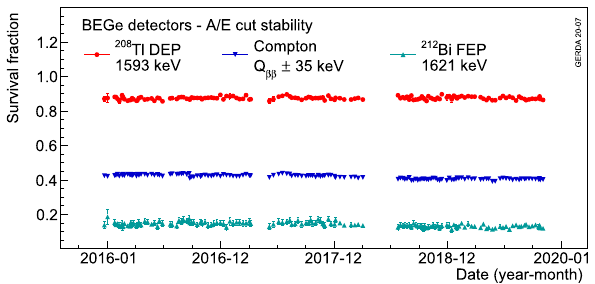
Fig. 8 Averagesurvivalfractionsofeventsinthe 208 TlDEP, 212 BiFEP and CC( Q ββ ) for BEGe detectors as a function of time. Each data point represents a calibration run with its statistical uncertainty